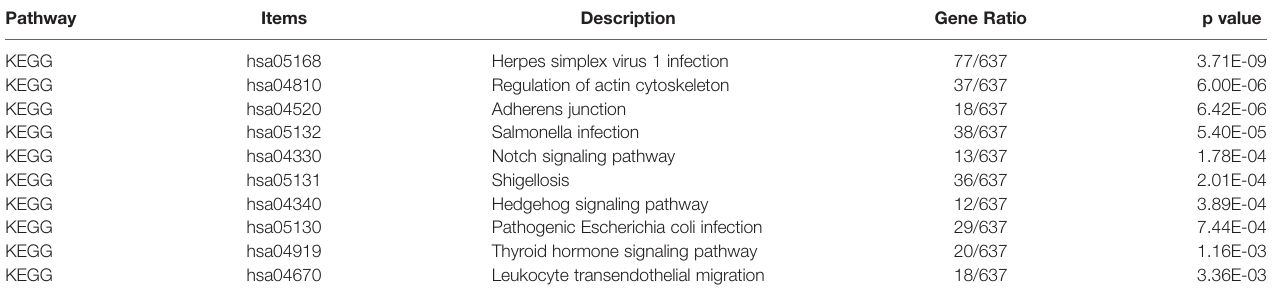
TABLE 3 | KEGG pathway enrichment of co-expression genes with LINC00654. Pathway